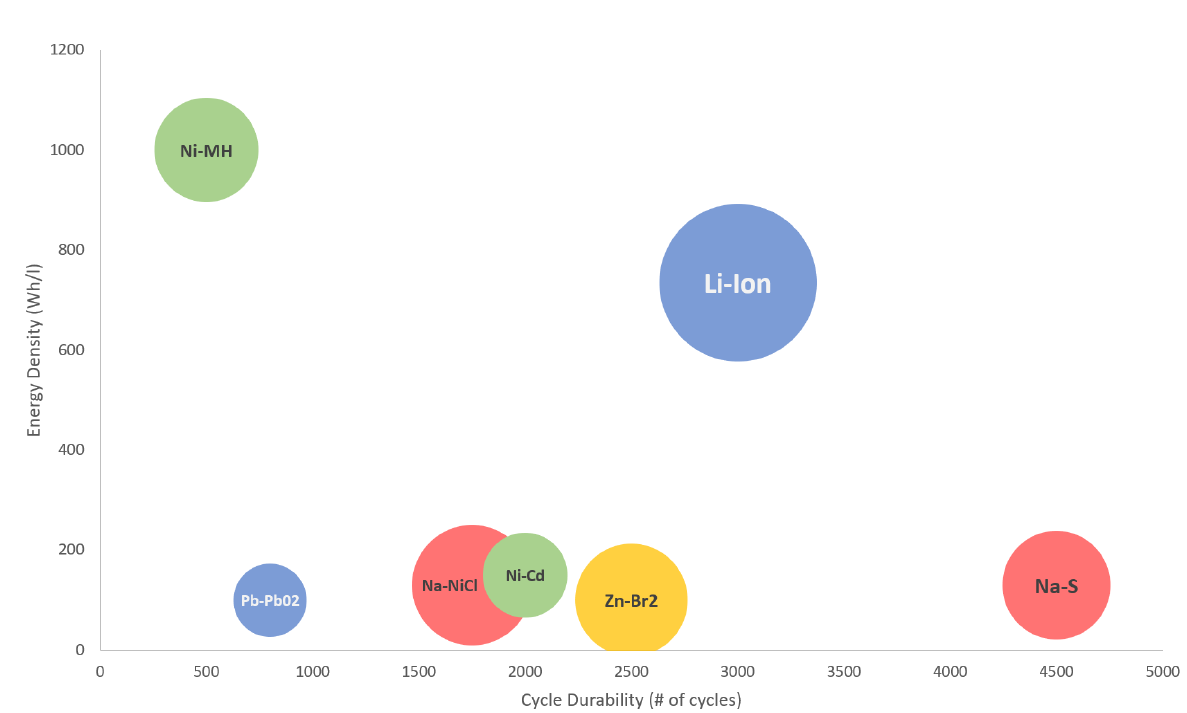
Figure 6. A comparison of battery technologies in terms of their Cycle Durability (x-axis), Energy Density (y-axis), Specific Energy (bubble size), and Working Temperature (bubble color). Note that warm colors represent higher working